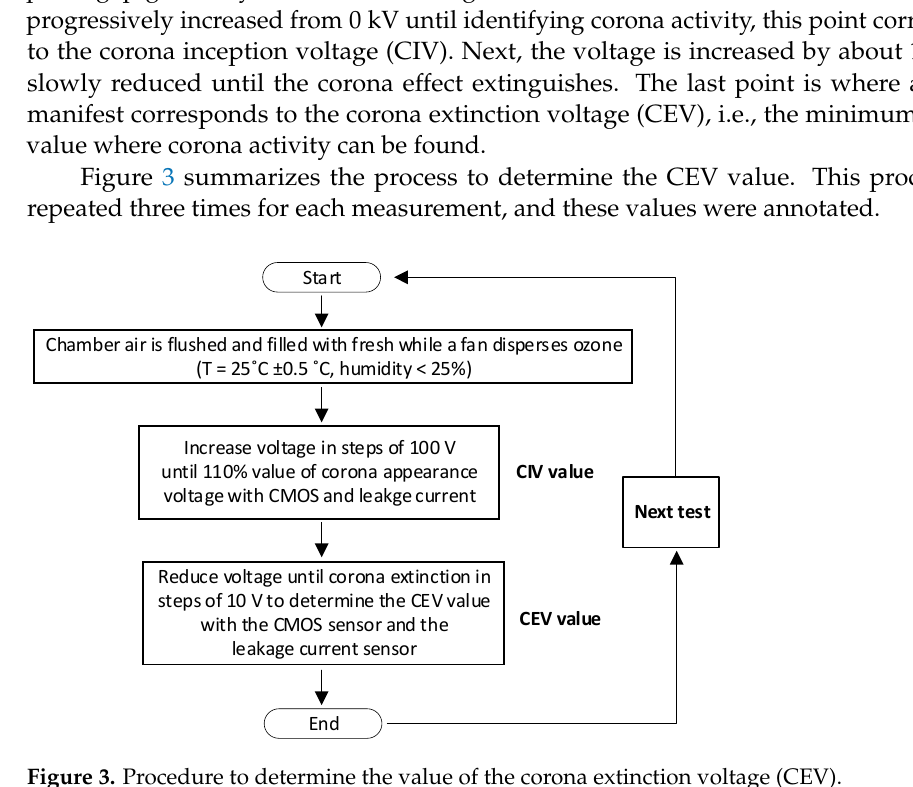
Table 1. Tests performed (three consecutive repetitions each test).